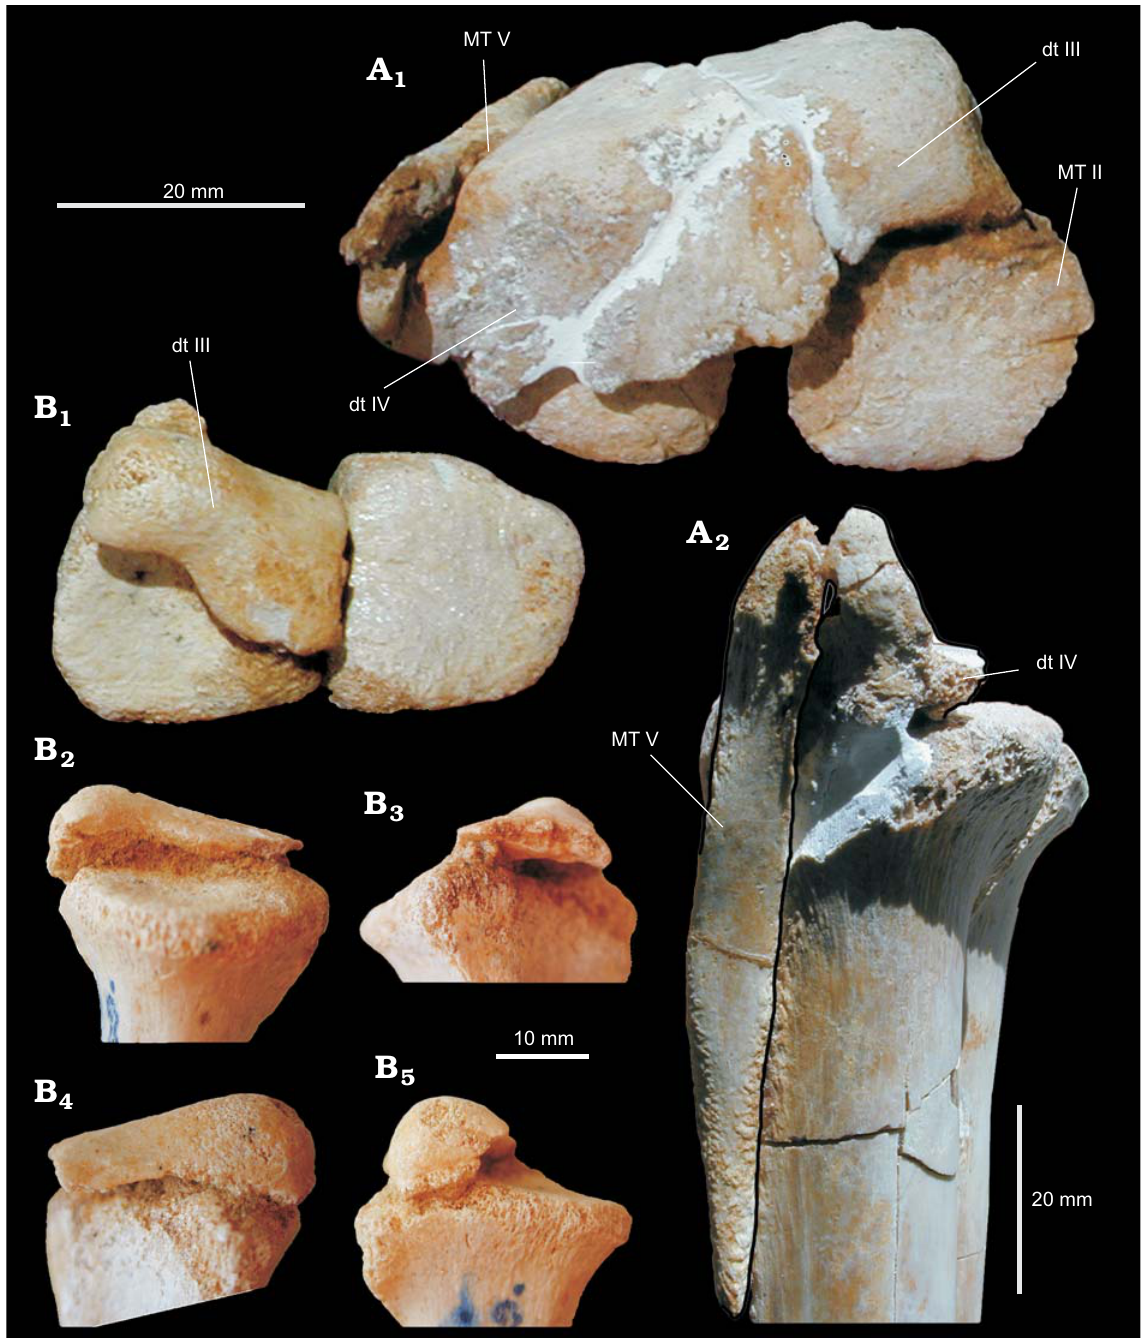
Fig. 7. Crested theropod dinosaur Elmisaurus rarus Osmólska, 1981; right ( A , MPC-D 102/006) and left ( B , MPC-D 102/007) tarsometatarsus from Nemegt Formation (Upper Cretaceous), Western Sayr of Nemegt locality, Mongolia; in dorsal (A 1 , B 1 ), anterior (B 2 ), lateral (B 3 ), posterior (B 4 ), and medial (B 5 ) views. Contact between distal tarsal IV and fifth metatarsal (A 2 ). Abbreviations: dt III, third distal tarsal; dt IV, fourth distal tarsal; MT II, second metatarsal; MT V, fifth